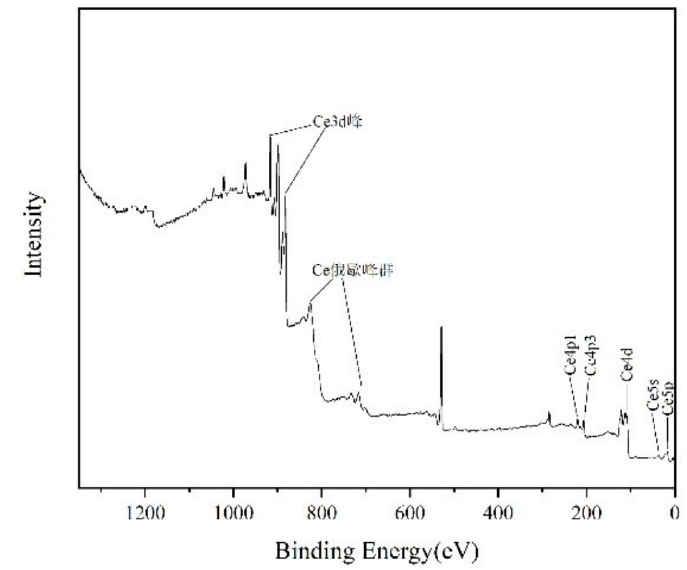
Figure 7. XPS results of combustion products. Table 8. XPS semiquantitative analysis results. Ce Powder